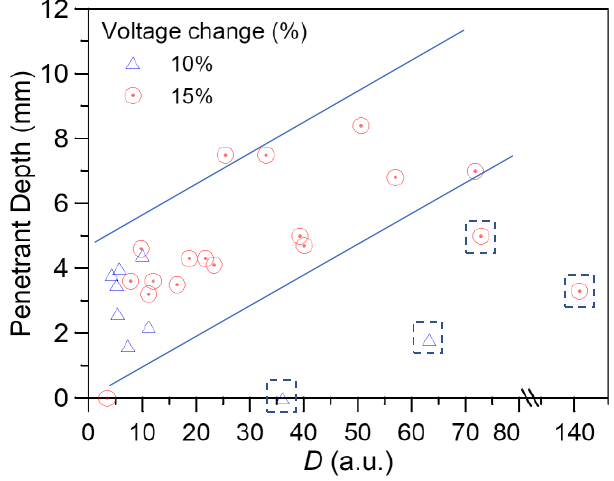
Figure 15. D values just before penetrant treatment versus the debonding length under or in the close vicinity of FBGs.